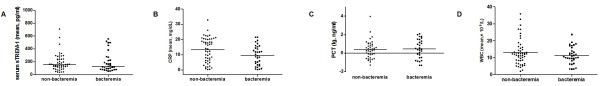
Comparison of diagnostic values for bacteremia. The diagnostic values of sTREM-1, CRP, and PCT levels and WBC count for bacteremia were compared. The dots denote individual values, and the bars denote means